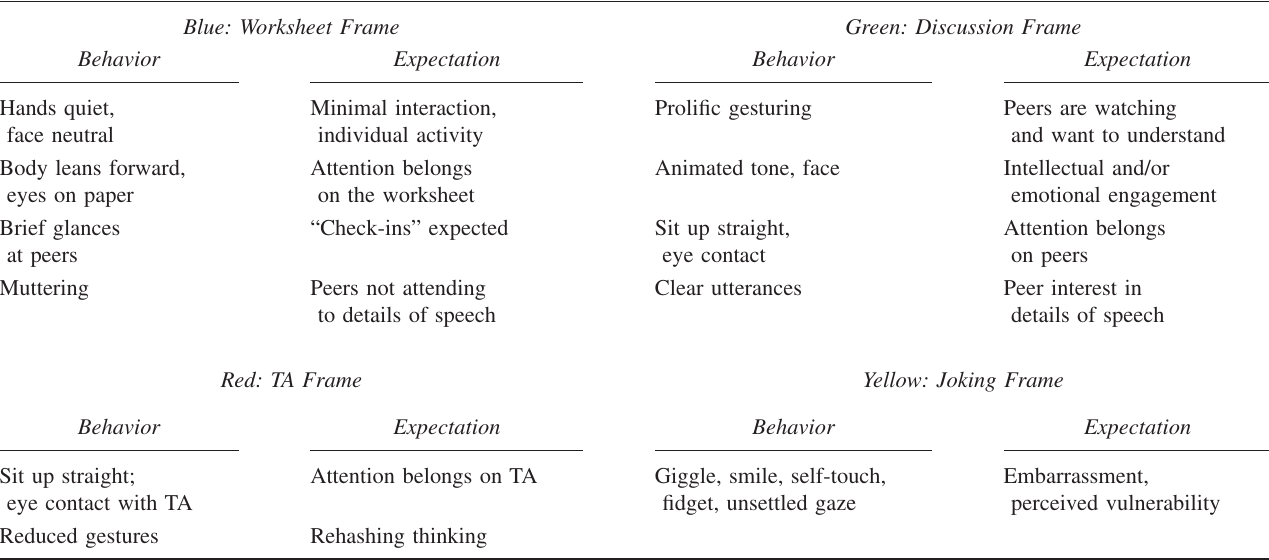
TABLE I. Specific behaviors found in each cluster and expectations likely to be associated with those behaviors. Blue: Worksheet